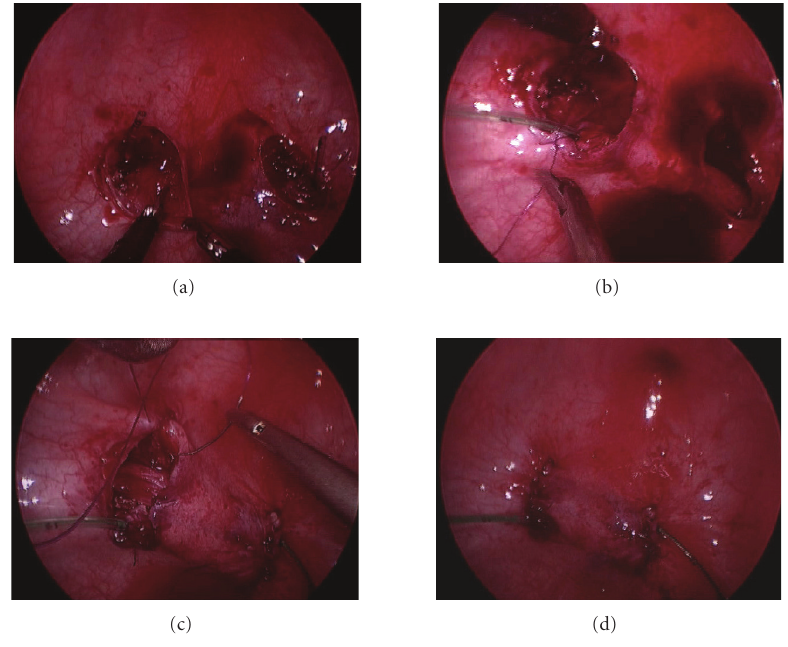
Figure 5: (a) Creation of the submucosal tunnels started by gently lifting up on mucosa and sharp dissection of the appropriate plane. (b) The right ureter has been passed through the tunnel and sutured to the original hiatus on the contralateral side. (c) Both ureters have been transposed and sutured in place. The left mucosal opening is then closed with absorbable suture. (d) Completed repair prior to removing feeding